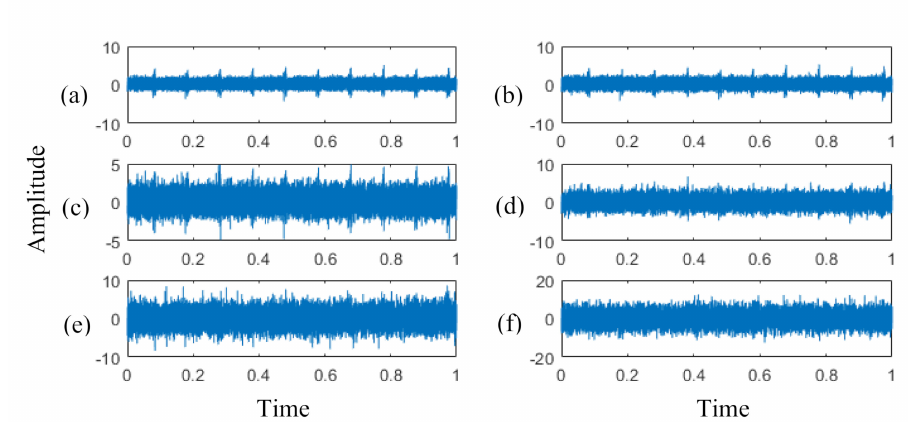
Figure 9. The simulated signal with added noise, ( a ) no noise, ( b ) 10 dB, ( c ) 5 dB, ( d ) 0 dB, ( e ) − 5 dB, and ( f ) − 10 dB of noise.